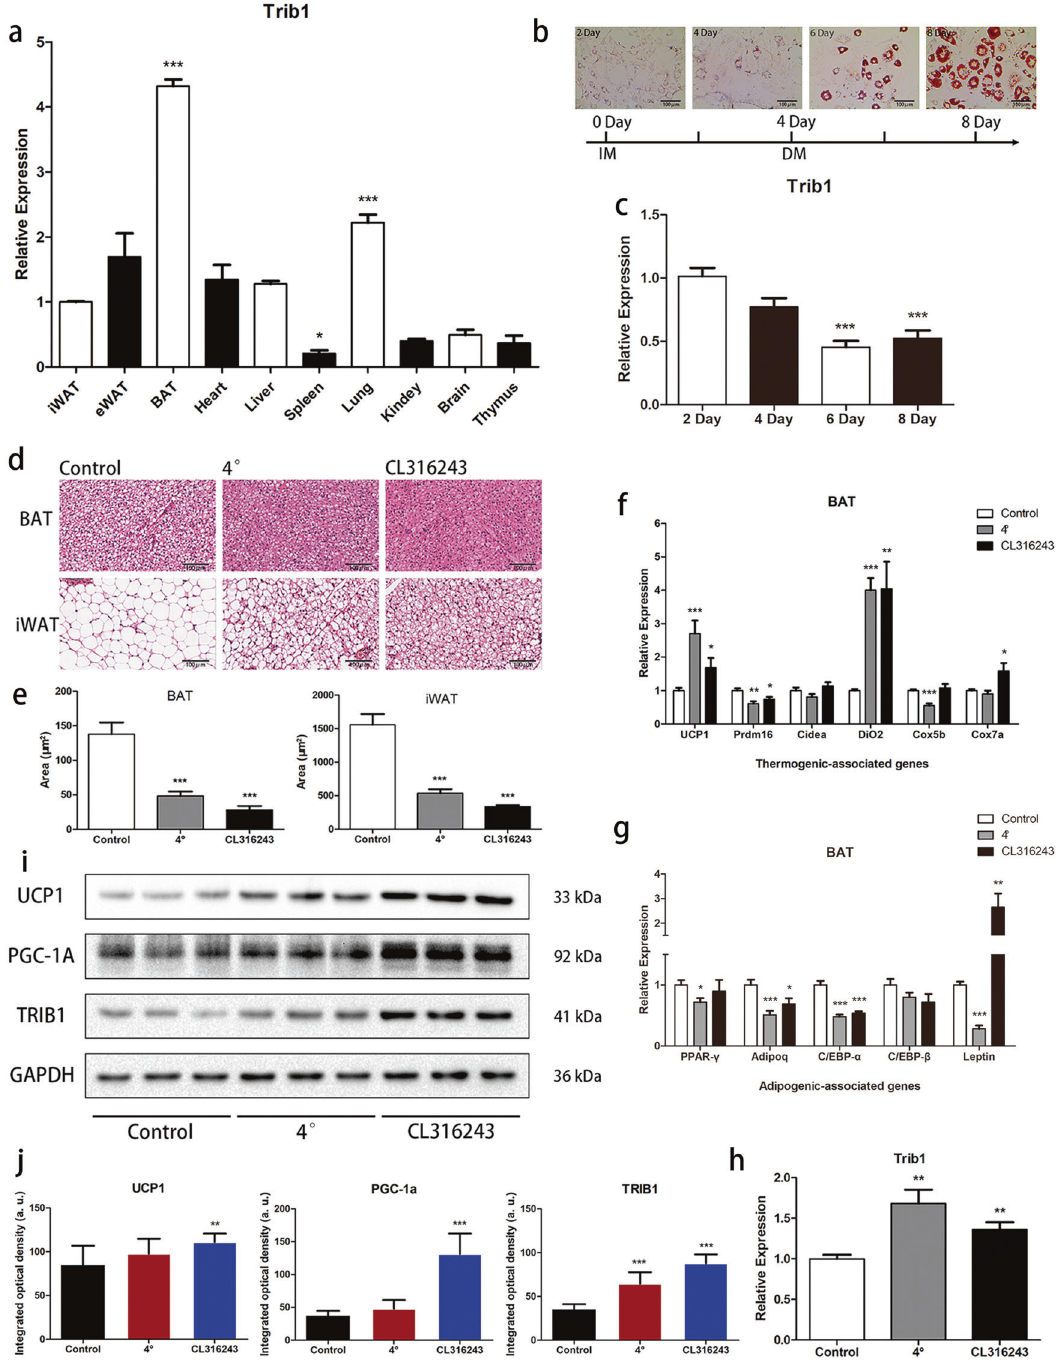
Fig. 1 After adrenaline stimulation, the expression of Trib1 in brown adipose increased. a The mRNA level of Trib1 in a variety of organs and tissues of normal C57BL/6J mice. b , c Lipid drop oil red staining and mRNA level of Trib1 in 3T3-L1 cells during adipogenesis. Scale bar: 100 μ m. d , e H&E-stained and lipid droplet area statistics of BAT and iWAT sections obtained from the C57BL/6J mice treated with cold exposure or CL316243 ( β 3-adrenoceptor agonist). Scale bar: 100 μ m. f – h After CL316243 treatment, the mRNA levels of Trib1 and thermogenesis-related genes in BAT. i , j After CL316243 treatment, TRIB1 and thermogenic protein in BAT. BAT, brown adipose tissue; iWAT, inguinal white adipocyte tissue; eWAT, epididymal white adipocyte. In the bar fi gure, each data represents mean ± SEM ( n = 6). wild-type and Trib1 -knockout mice to explore the effects of Trib1 knockout on mitochondrial function. A total of 11,042 and 11,002 genes showed greater than a two-fold expression level change in wild-type and Trib1 -knockout mice, respectively (Fig. 4a); the cal functions, including glucose metabolism, lipid metabolism, and volcano plot showed that 660 genes were upregulated and 405 oxidative phosphorylation. We sequenced the genes in the BAT of